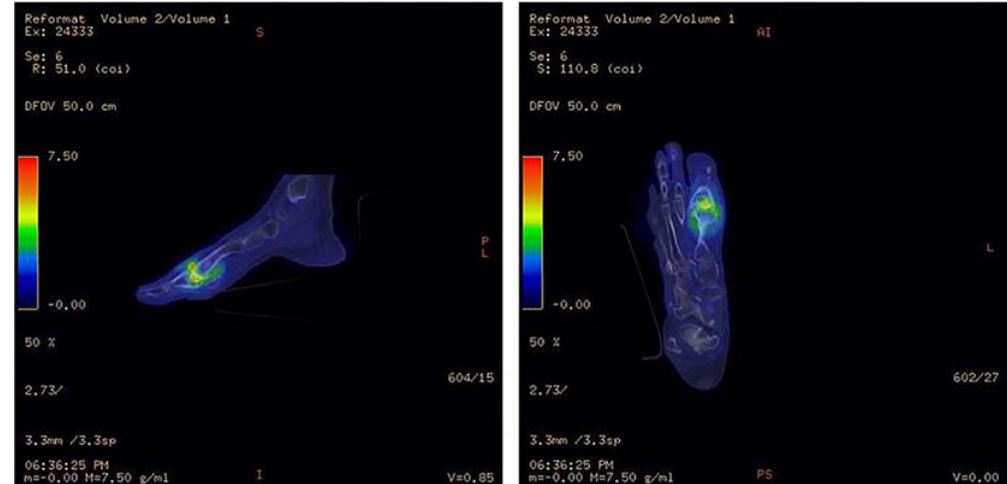
Figure 10. 18 F-FDG PET/CT illustrating infection of the metatarsophalangeal joint. Increased 18 F-FDG uptake in the first metatarsophalangeal joint is seen in the bone and soft tissues. Signal uptake in this region is much greater than that of the surrounding healthy tissue, indicating pathologically increased glucose metabolism. Image has been reproduced with permission from Iyengar et al., J Clin Orthop Trauma, published by Elsevier, 2021 [117].